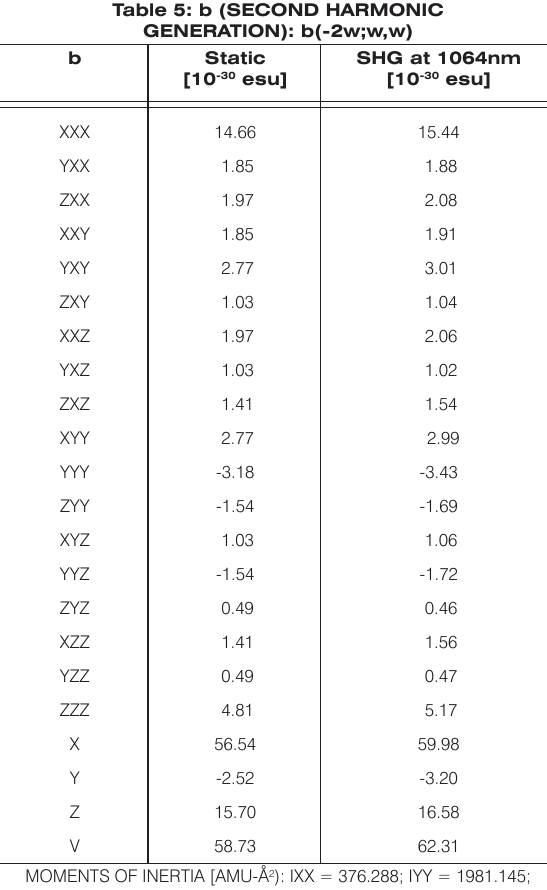
Table 1. Calculated SHG generation. Table 5: b (SECOND HARMONIC GENERATION):